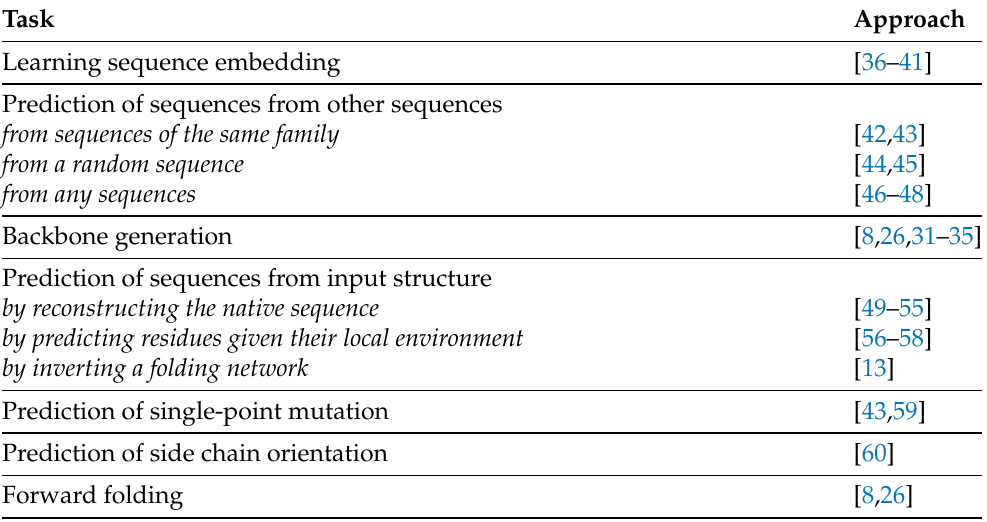
Table 1. Protein design-related tasks tackled by